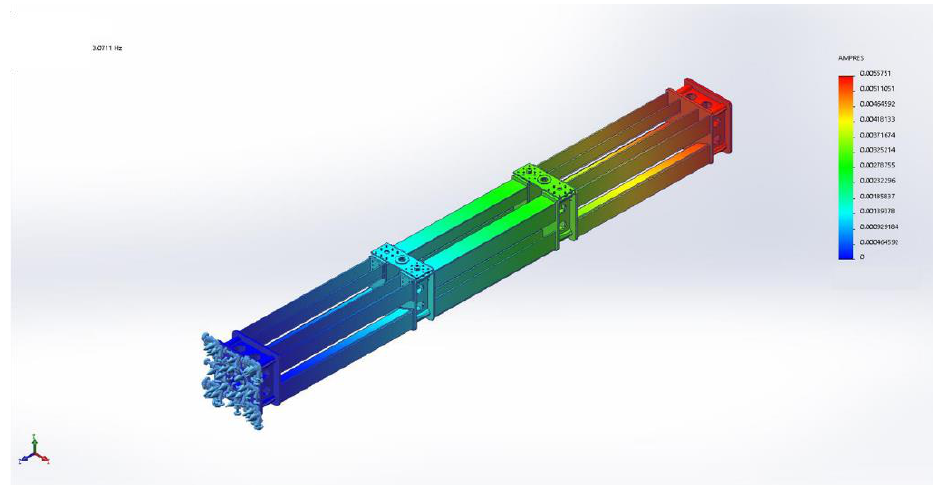
Figure 7. Natural frequency analysis.